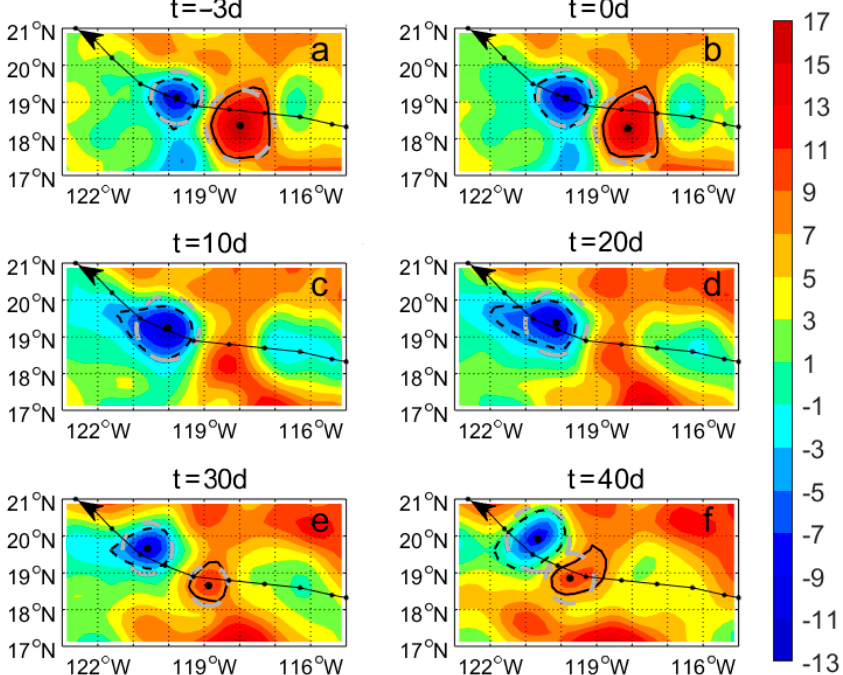
Figure 2. Observed temporal and spatial evolution in the surface structure of a mesoscale dipole eddy before and after the passage of TC Hernan: ( a – f ) are satellite-observed SLA (unit: cm) at − 3, 0, 10, 20, 30, and 40 days after the TC, respectively. The dotted lines represent the track of the TC, the small black dots represent the location of the TC center every 6 h, and the black arrows represent the direction of the TC’s translation. The dashed and solid contours outline the approximate edges of the COE and the AOE, respectively. The large black dots represent the locations of the centers of the COE or the AOE. The gray dashed rings represent the equivalent area circles of the COE or the AOE.